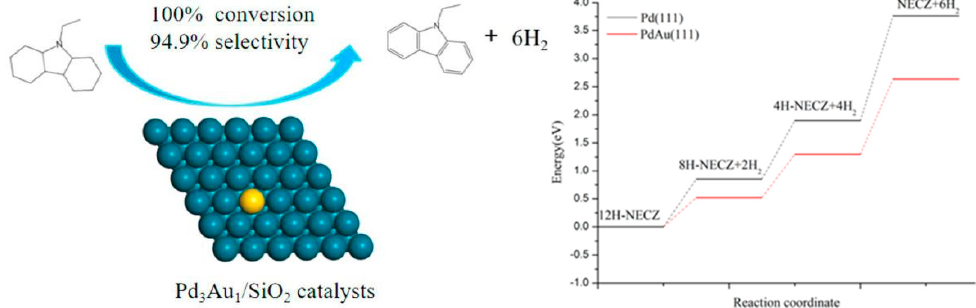
Figure 8. DFT-calculated energy profile of 12H-NECZ dehydrogenation to N-ethylcarbazole (NECZ) on the Pd (111) and PdAu (111) surfaces; copyright (2019), ACS Appl. Energy Mater.